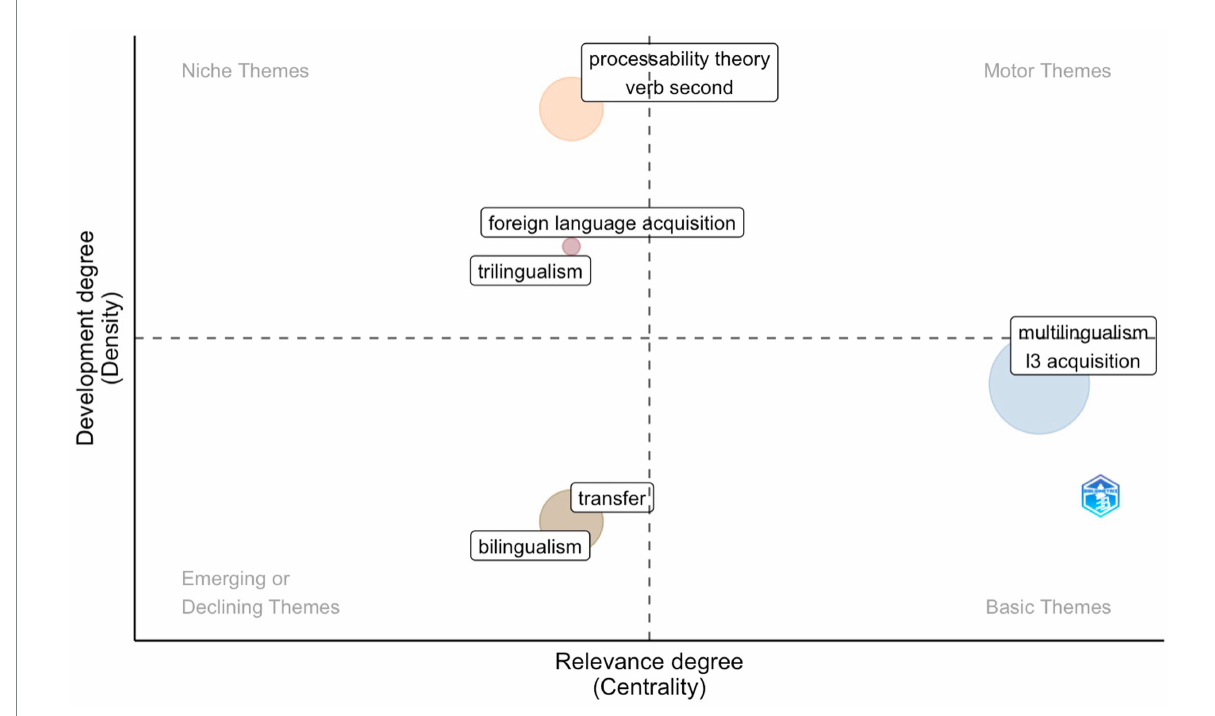
FIGURE 10 Thematic map showing clusters and the author’s keywords during the first period (1984-2008) identified by the co-occurrence